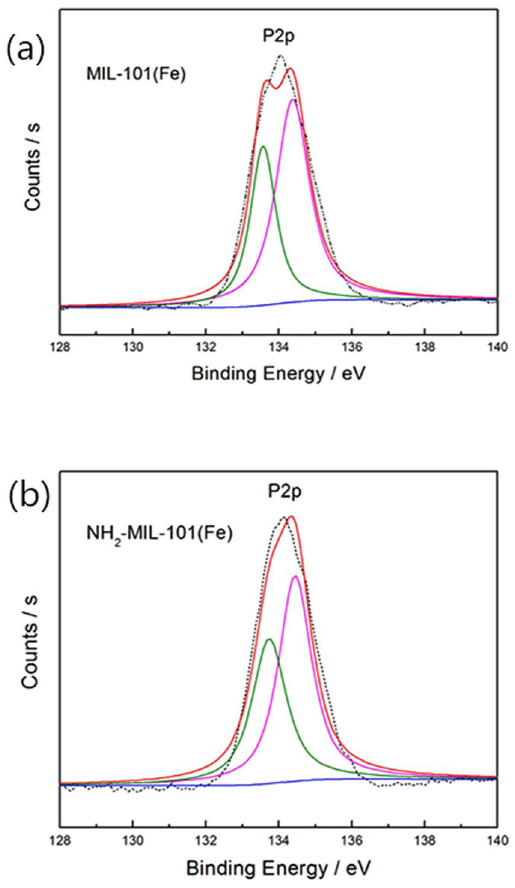
Figure 18. P2p XPS spectra of the ( a ) MIL-101(Fe) and ( b ) NH 2 -MIL-101(Fe) adsorption of